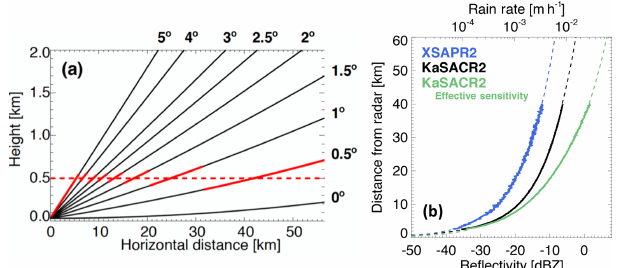
Figure 7. (a) PPI scan geometry and (b) theoretical sensitivity of the XSAPR2 (blue) and KaSACR2 (black), along with the KaSACR2 “effective” sensitivity, considering it is affected by gas attenuation